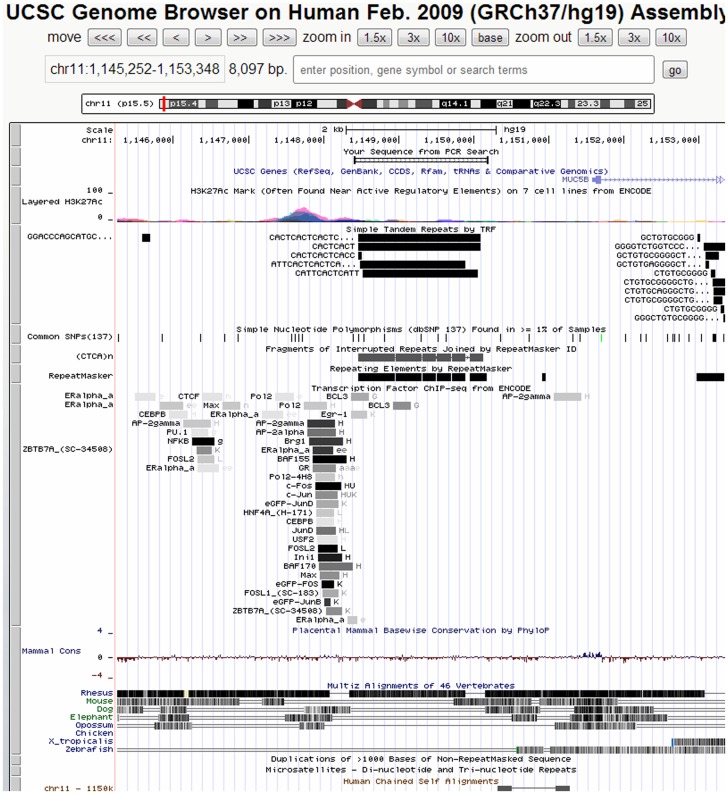
Location and genomic features of the upstream region of the human MUC5AC gene.The studied MUC5AC-u repetitive region (red and black boxes) is located about 1.5 kb upstream from the MUC5AC mRNA transcript start, the MUC5AC transcript is incorrectly annotated to MUC5B (UCSC Genome Brower, GRCh 37/hg 19). This locus snapshot illustrates its location, the PCR coverage in amplifying the target region (open box with vertical lines), the major repetitive genomic features defined by Repeat Master, the histone H3 lysine 27 acetylation (H3K27AC) enrichment and reported transcription factor binding sites, and many more other features.